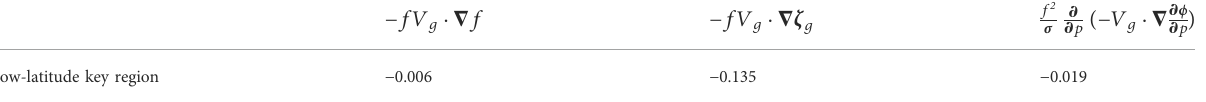
TABLE 4 Quasi-biweekly components of geopotential tendency equation over the low-latitude key region (unit: 10 − 10 s − 2 ).